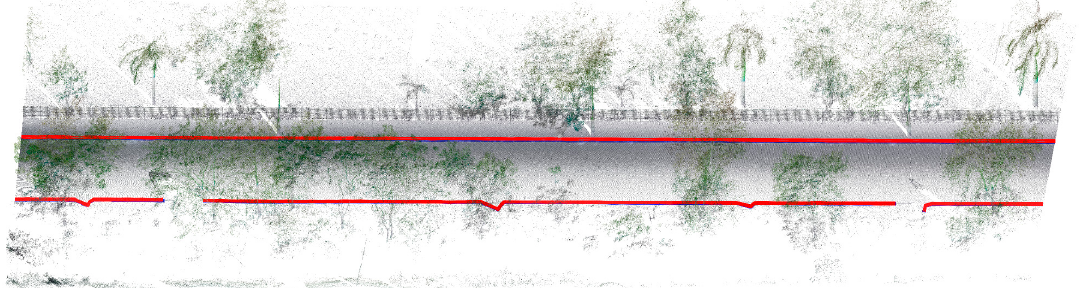
Figure 17. Propose method produced a top and bottom curb break line.